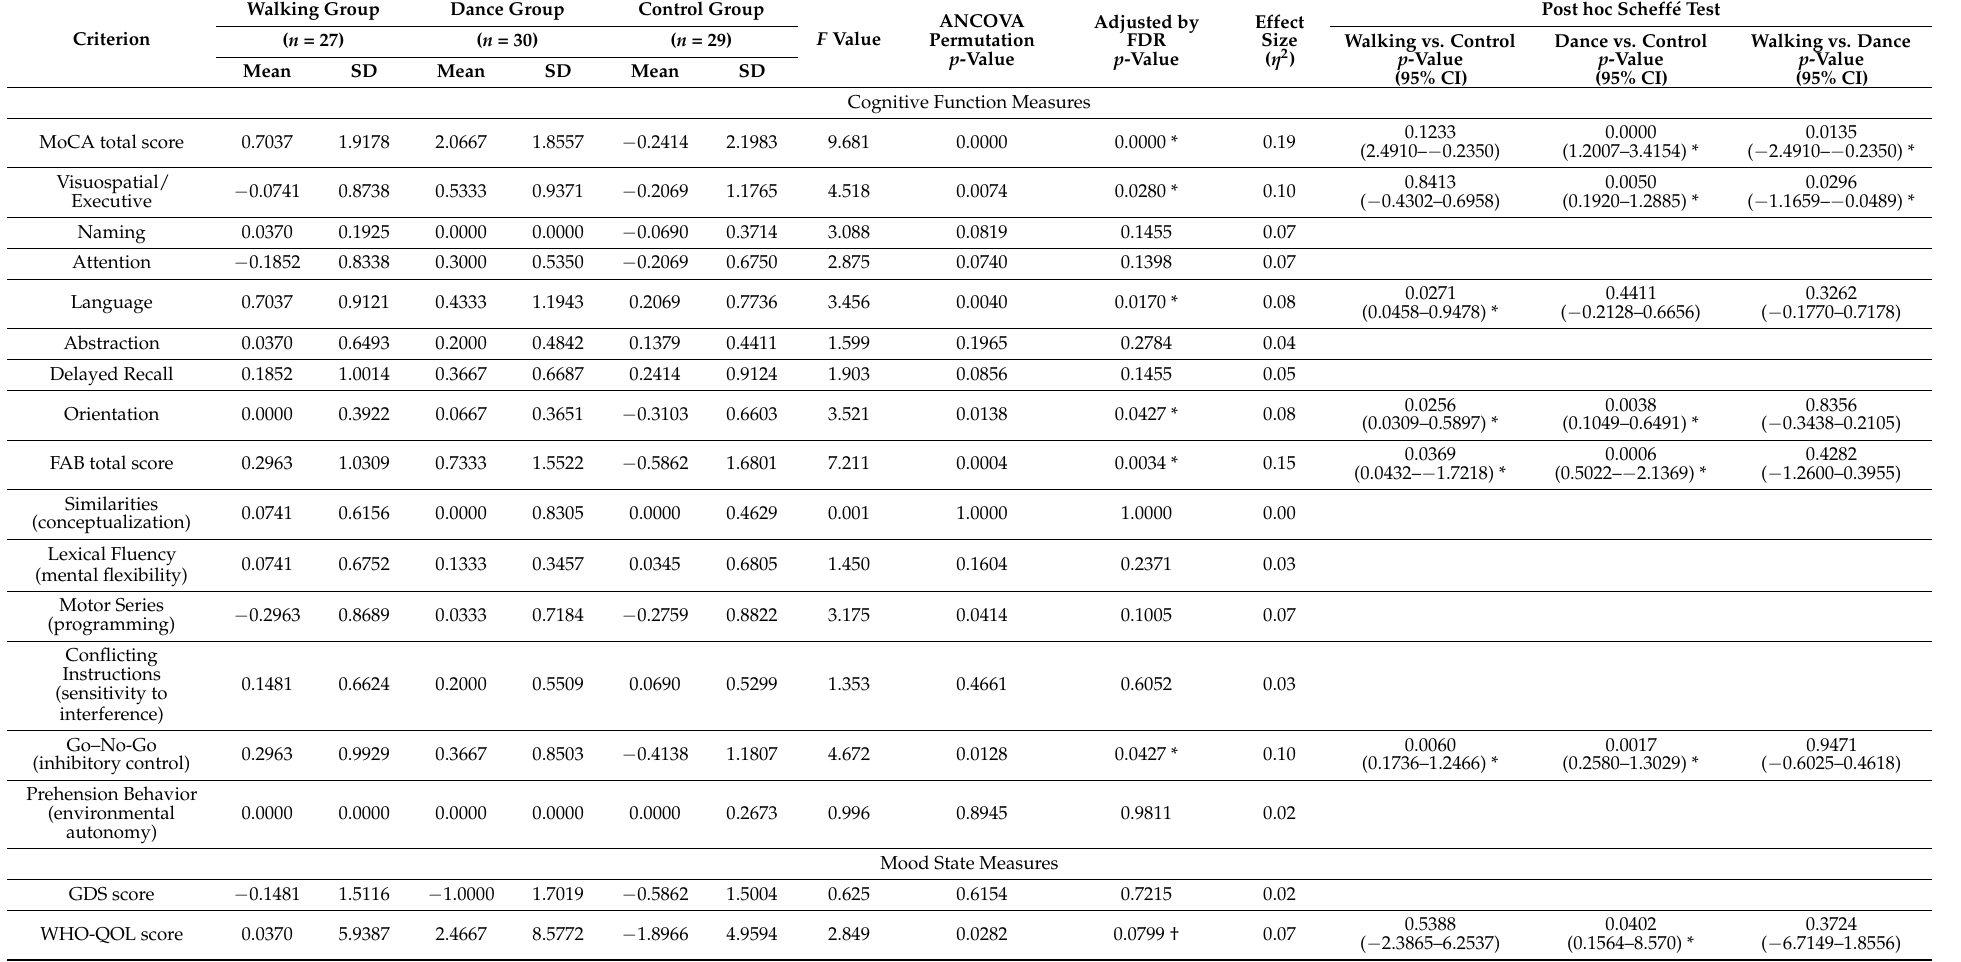
Table 2. Comparison of the changes in scores between the three groups following the 4-week